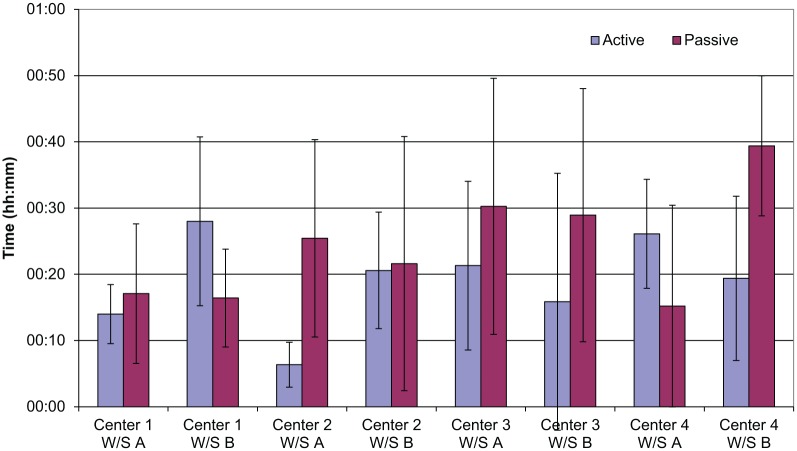
Monitoring results.